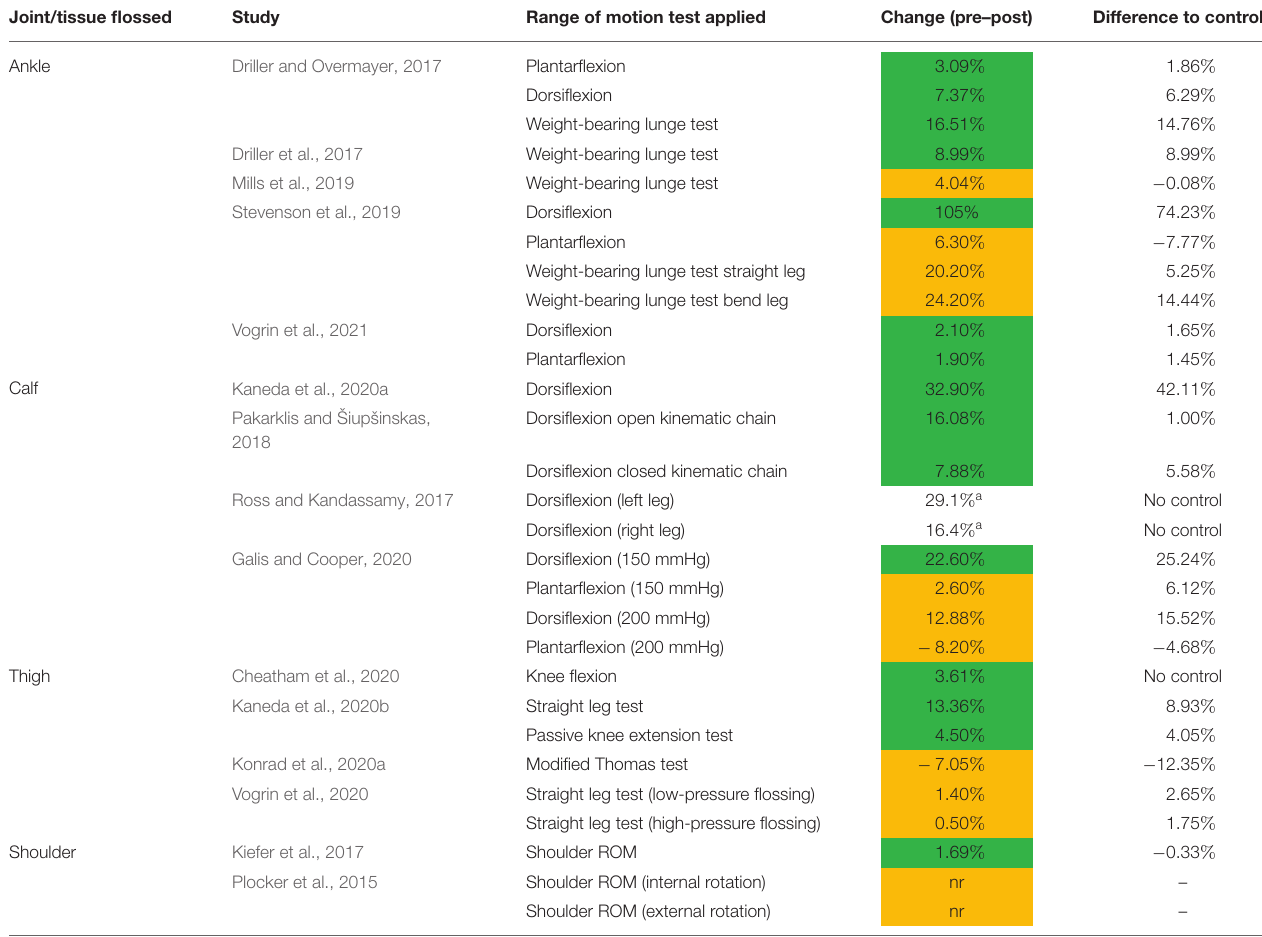
TABLE 2 | Summary of the results of the studies which investigated the acute effect of flossing on range of motion (before and after difference). Joint/tissue